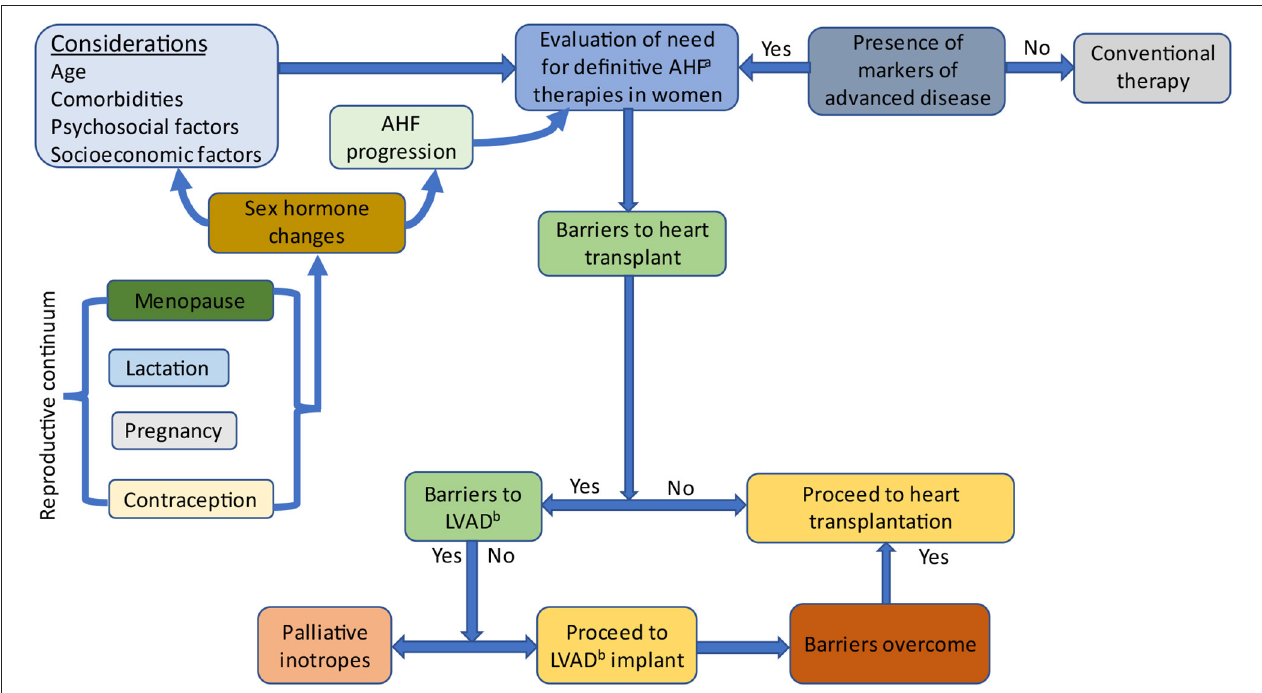
FIGURE 2 | Evaluation of women for advanced heart failure therapies. Sex-specific factors affect hormonal levels and include pregnancy, lactation, contraception and menopause. Sex hormones influence heart failure progression and factors which are considered when evaluating women for advanced heart failure therapies. AHF, Advanced heart failure; LVAD, Left ventricular assist